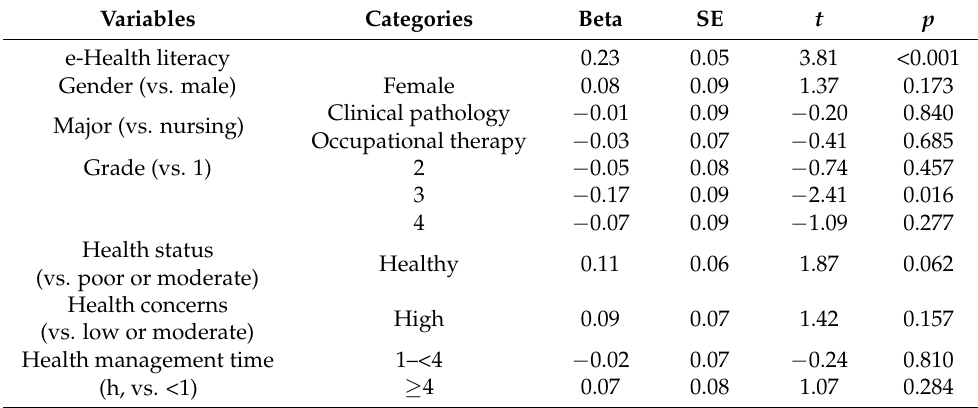
Table 4. Regression results in infection-preventive